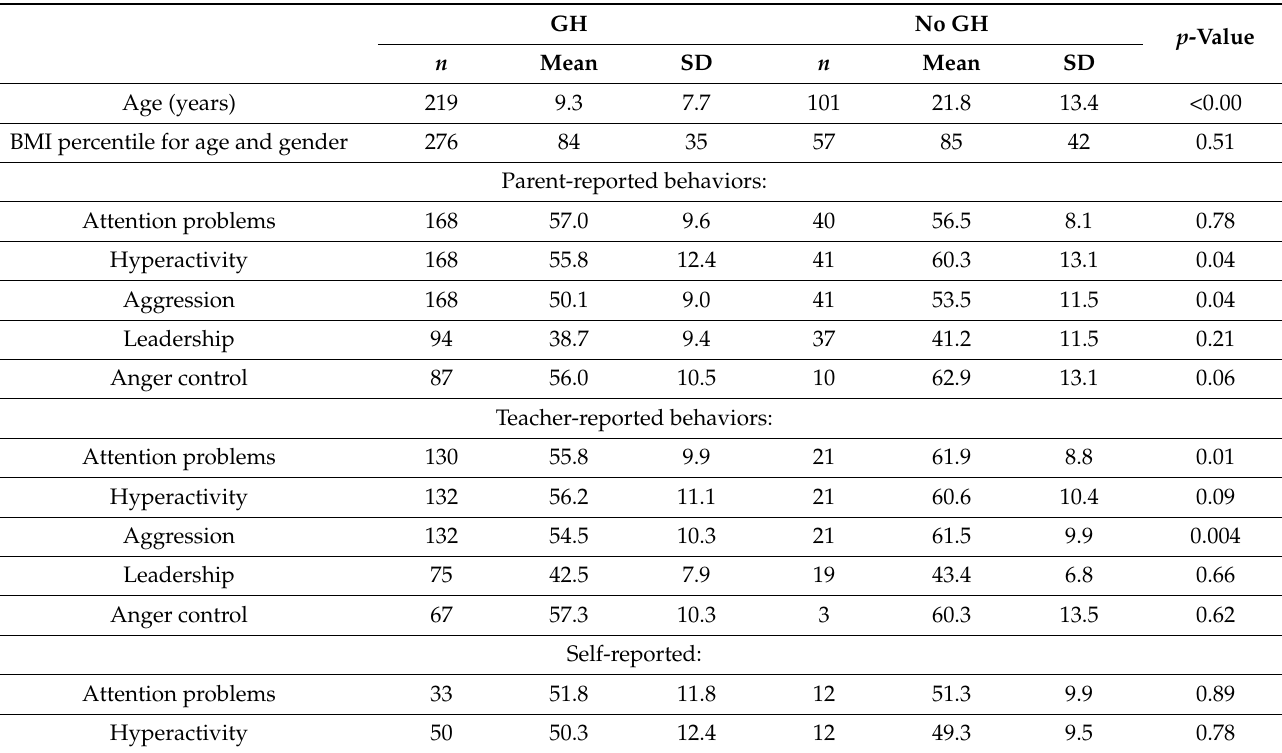
Table 3. Demographics and behavior by growth hormone treatment in patients with